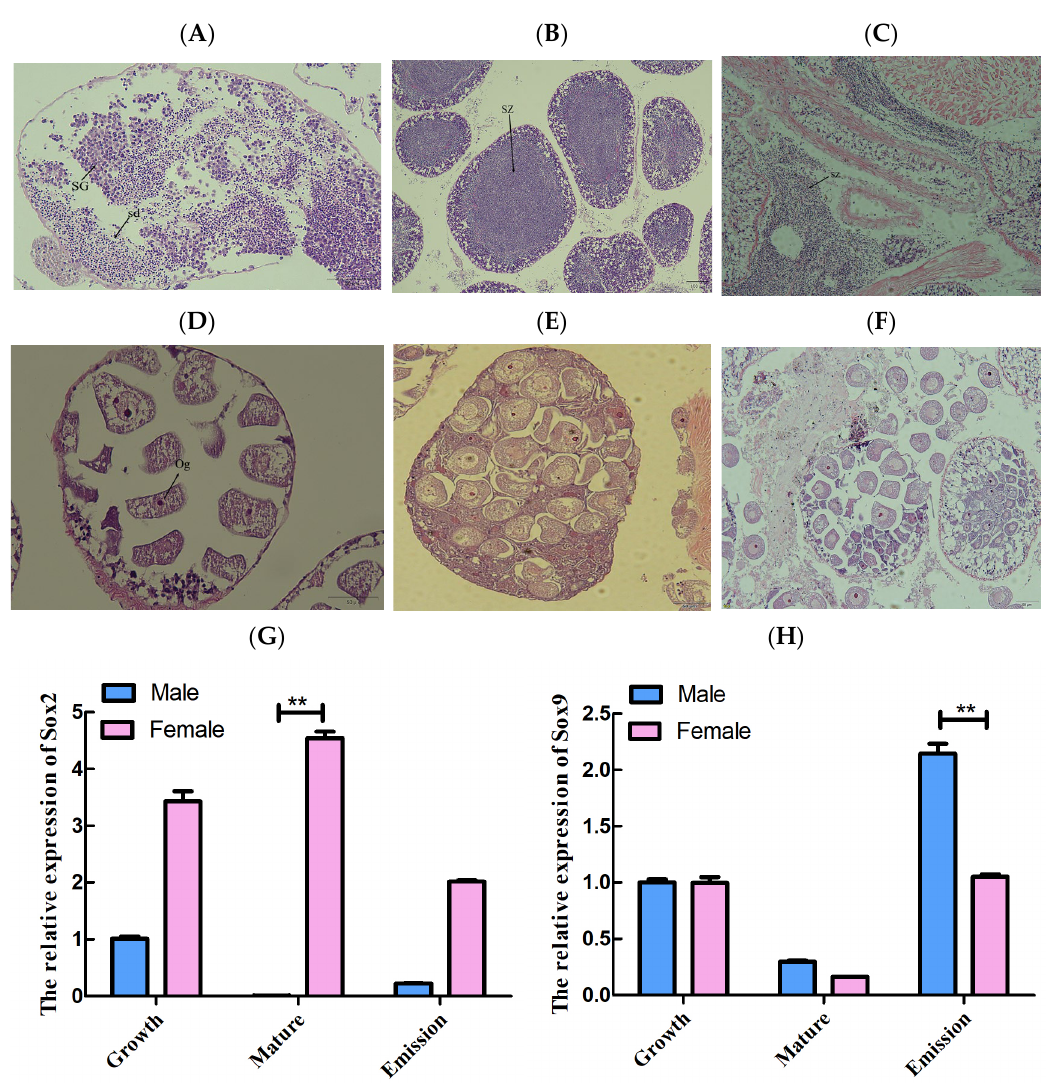
Figure 6. Paraffin sections of the Lutraria sieboldii gonad at different stages of development. ( A ) Growth stage, ( B ) maturation stage, and ( C ) emission stage of male L. sieboldii . ( D ) Growth stage, ( E ) maturation stage, and ( F ) emission stage of female L. sieboldii . ( G ) LsSox 2 and ( H ) LsSox 9. Expression of LsSox 2 and LsSox 9 at different stages of gonadal development in L. sieboldii . Each bar represented mean ± SEM (n = 3), asterisks above the bars indicate the results of Duncan’s test at ** p < 0.01. sd: spermatids; SG: spermatogonia; sz: spermatozoa. Og: oogonia.